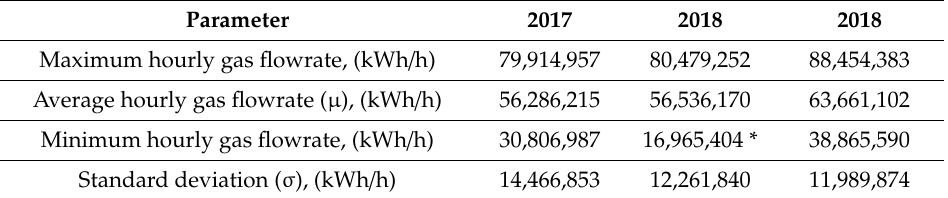
Table 6. Results from the data analysis performed concerning hourly gas flowrate in August 2017, and 2018 and 2019.